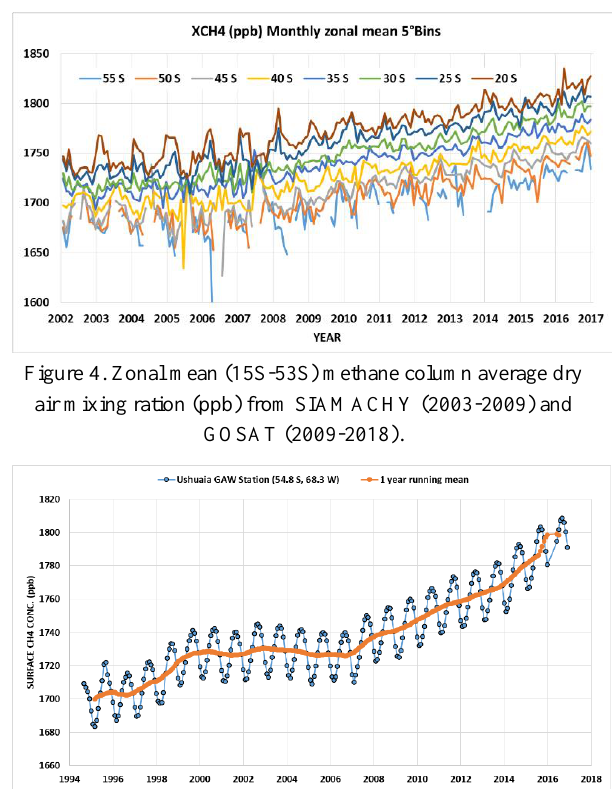
Figure 3. Latitudinal averages for EDGAR and GEAA methane inventory for 0.1° resolution. Figure 5. monthly surface concentrations of methane measured at the GAW station in Ushuaia (54.8°S, 64.3°W)(GAW,